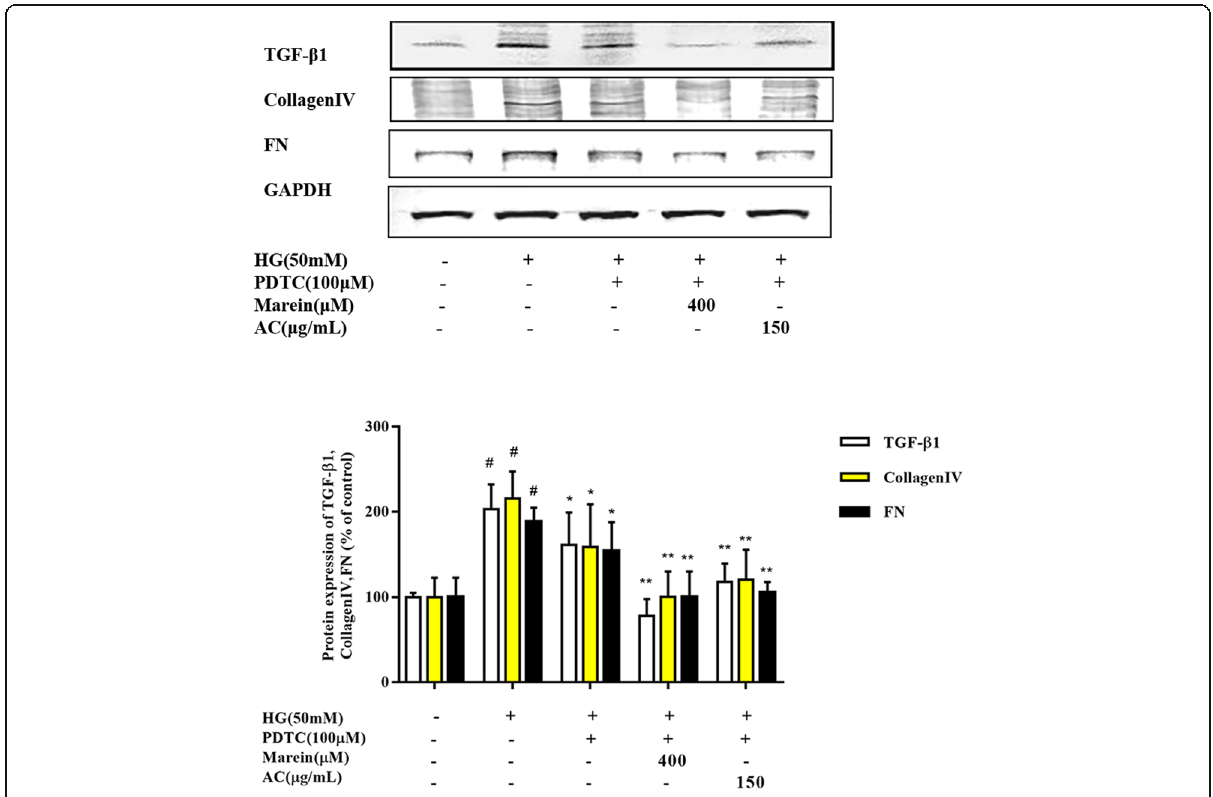
Fig. 8 AC and marein ameliorated fibrotic markers by regulating NF- κ B signaling. HBZY-1 cells were pretreated with AC and marein for 2 h, and then stimulated with PDTC, an NF- κ B inhibitor followed by NG or HG exposure for 24 h. Equal amounts of lysate were subjected to western blotting analysis to determine TGF- β 1, CollagenIV, and FN. Note: Values were expressed as the mean ± SD, n = 4. # P < 0.01 versus normal group; * P < 0.05 versus control group; ** P < 0.01 versus control